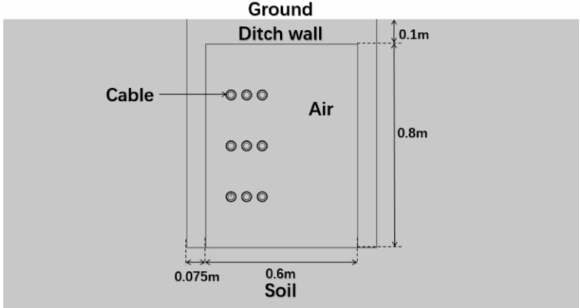
Figure 3. Two-dimensional geometric model of cable trench with triple three-loop